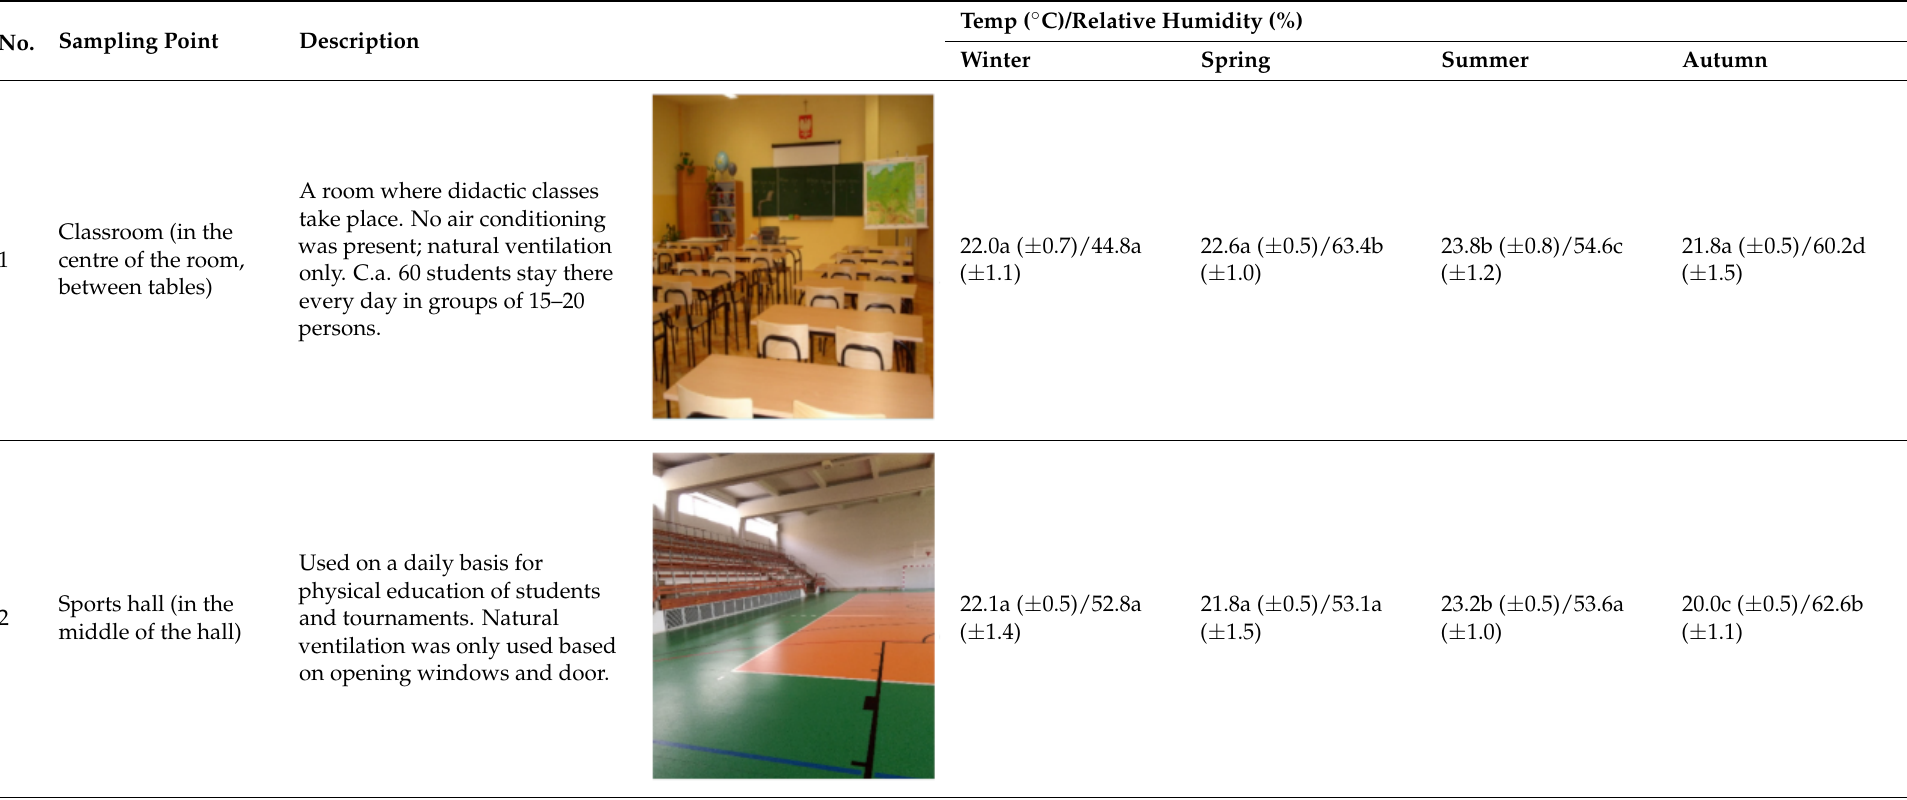
Table 1. Characteristics of the sampling points with physical parameters measured in the course of the annual study. Values of temperature and relative humidity sharing the same letter are not statistically different according to ANOVA followed by Tukey’s test ( p < 0.05). Pictures presented in the Table were taken during the study by Dagmara Drab and Justyna